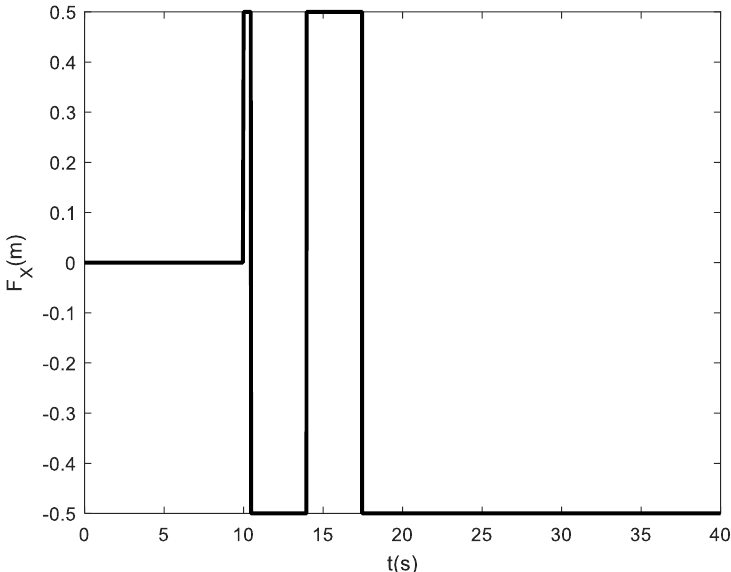
Figure 3. The curve of the disturbance in position X channel.